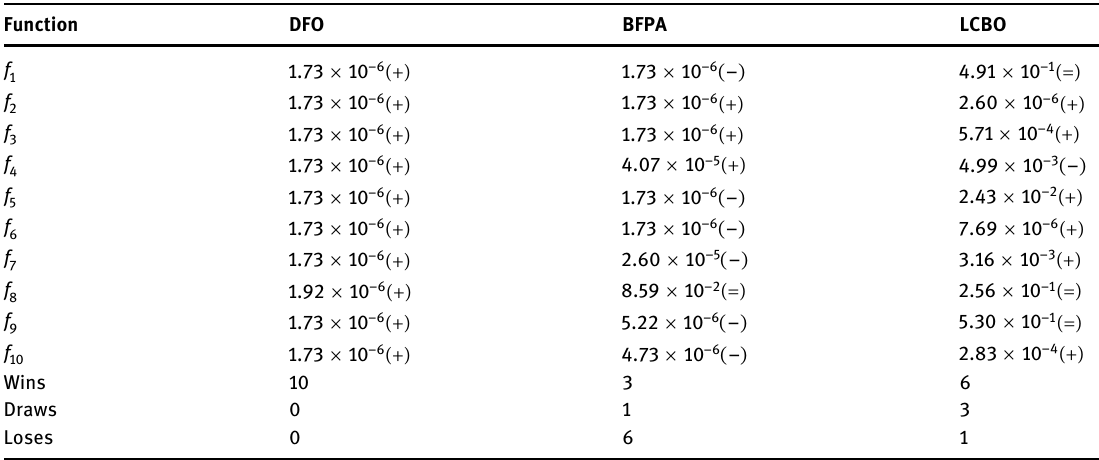
Table 10: The CEC 2020 ( = D 10 ) statistical analysis showing the Wilcoxon test p - value